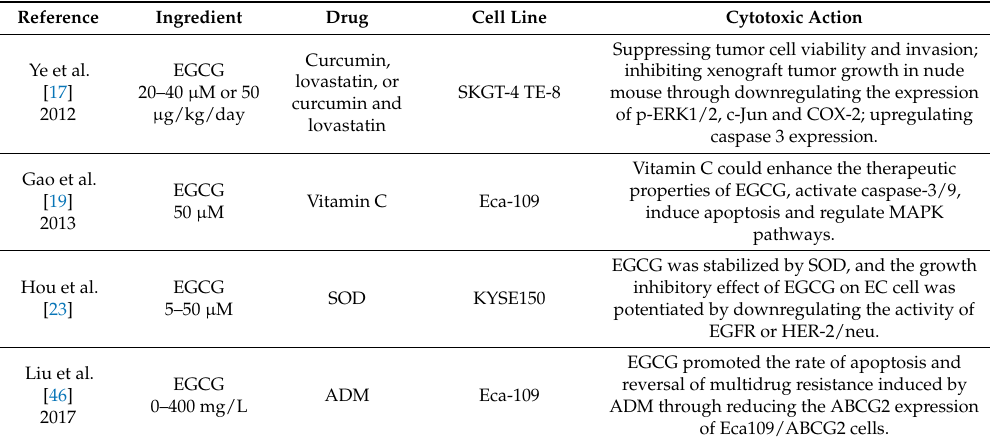
Table 4. Pharmaceutical synergistic effects of EGCG with other treatments on